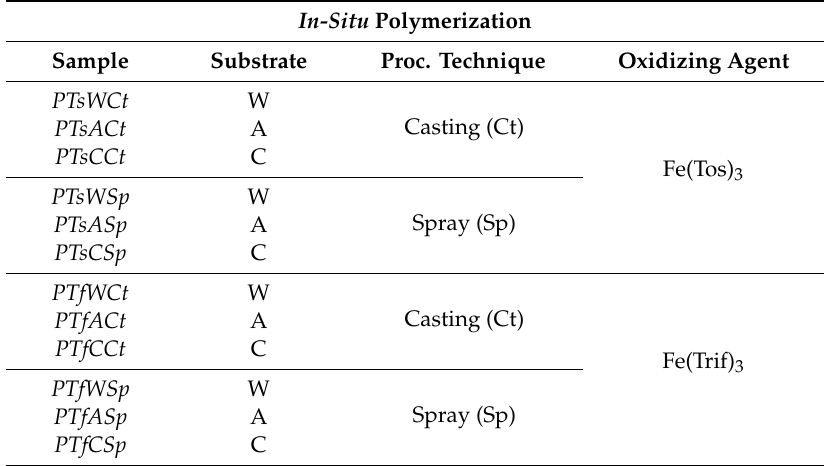
Table 1. Polythiophene-derivative / cellulose materials prepared by in-situ